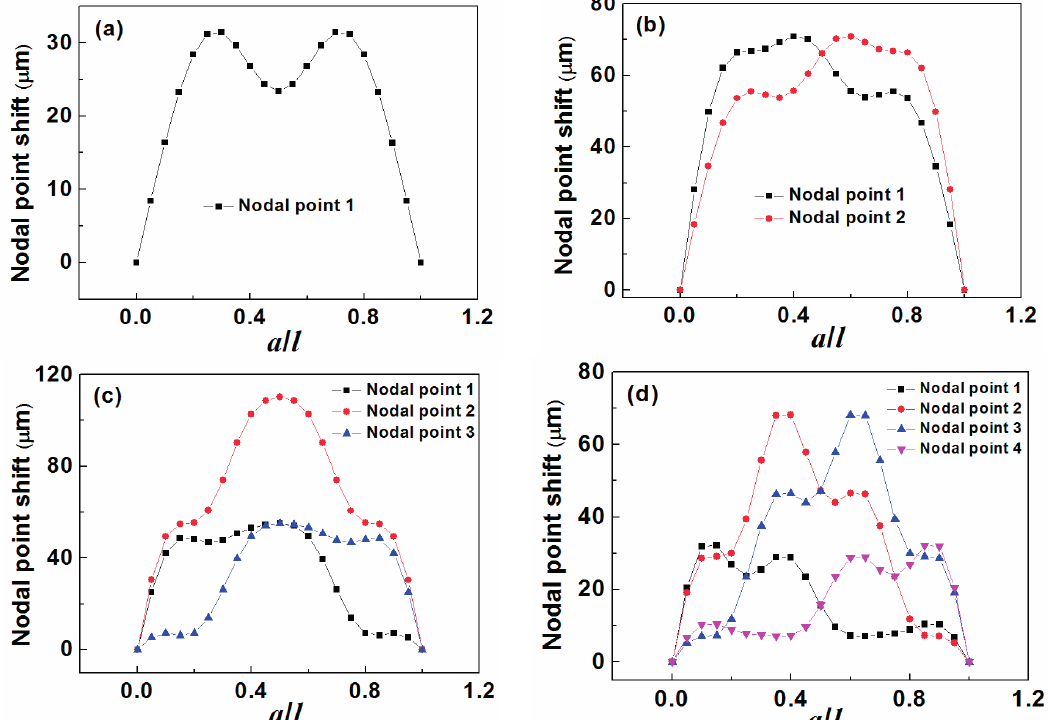
Figure 3. The plot of “nodal point” shift changing with mass load distribution ( a / l ) under ( a ) first order resonance mode; ( b ) second order resonance mode; ( c ) third order resonance mode; and ( d ) fourth order resonance